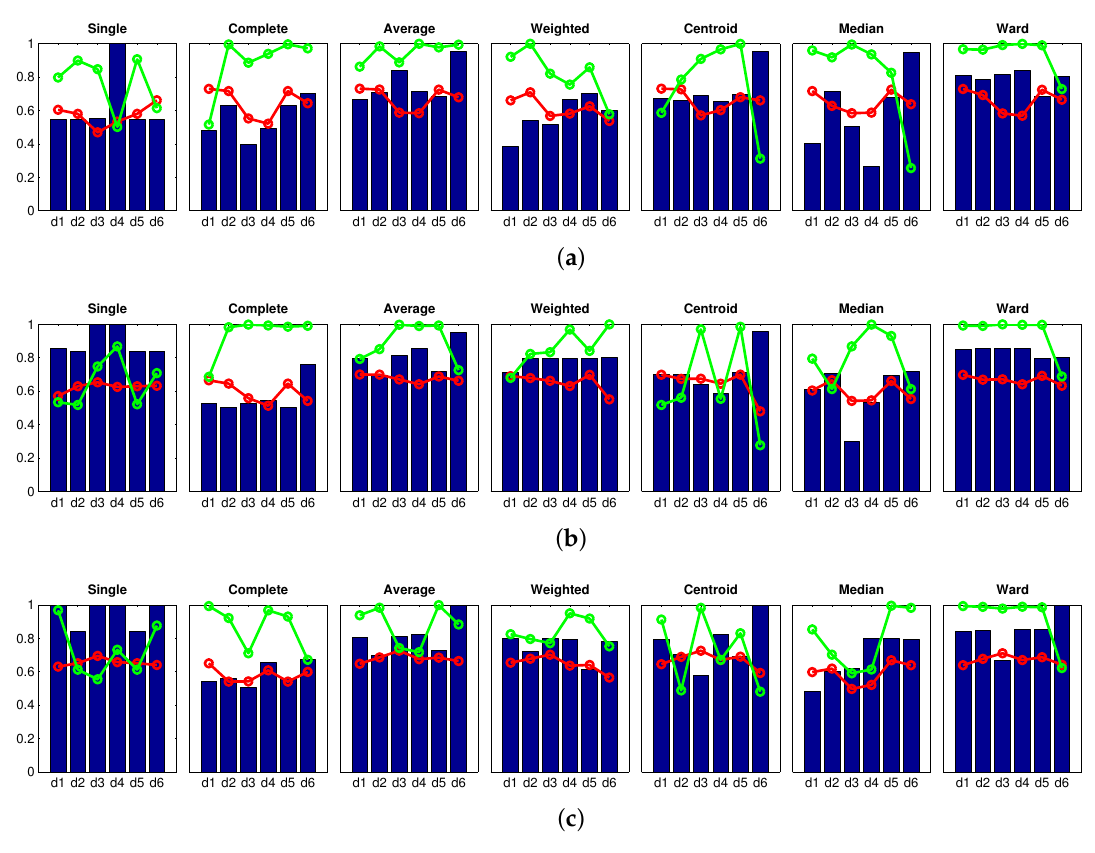
Figure 9. Legend: (cid:4) Accuracy c ; −◦− Correlation γ coph ; −◦− Inconsistency δ inconsist . Results of the high-level clustering using gist as global-appearance descriptor and ( a ) m = 4, k 6 = 4; ( b ) m = 4, k 6 = 8; ( c ) m = 4, k 6 =